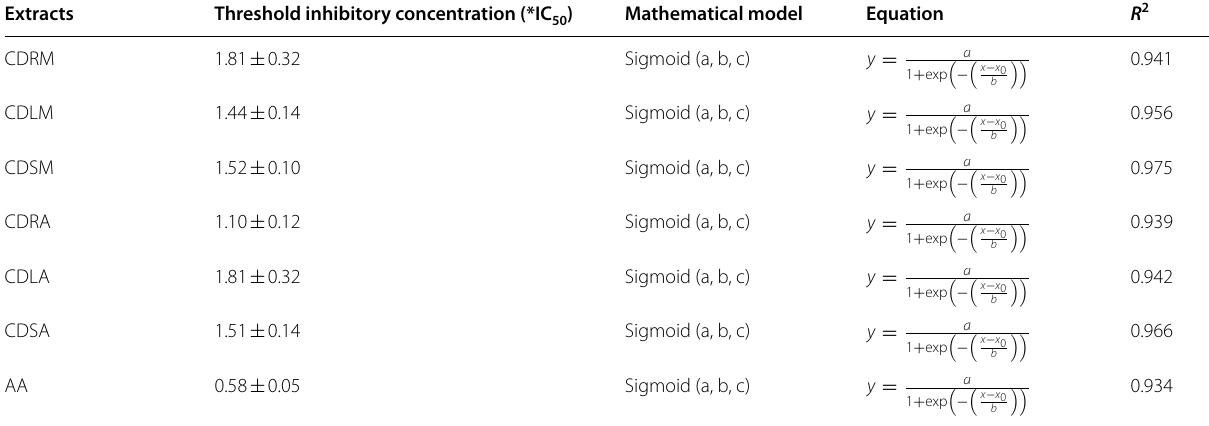
CDRM, C. dependens root methanol; CDLM, C. dependens leaves methanol; CDSM, C. dependens stem methanol; CDRA, C. dependens root aqueous; CDLA, C. dependens leaves aqueous; CDSA, C. dependens stem aqueous; AA, ascorbic acid *IC 50 is the concentration of extract or standard that scavenged 50% of the generated free radicals